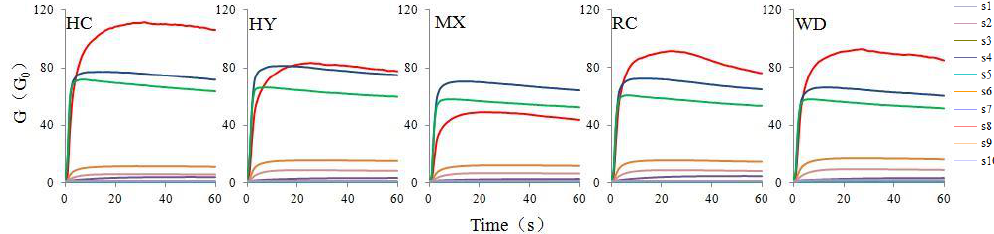
Figure 1. Typical responses of Chinese red peppers obtained by direct e-nose measurement.